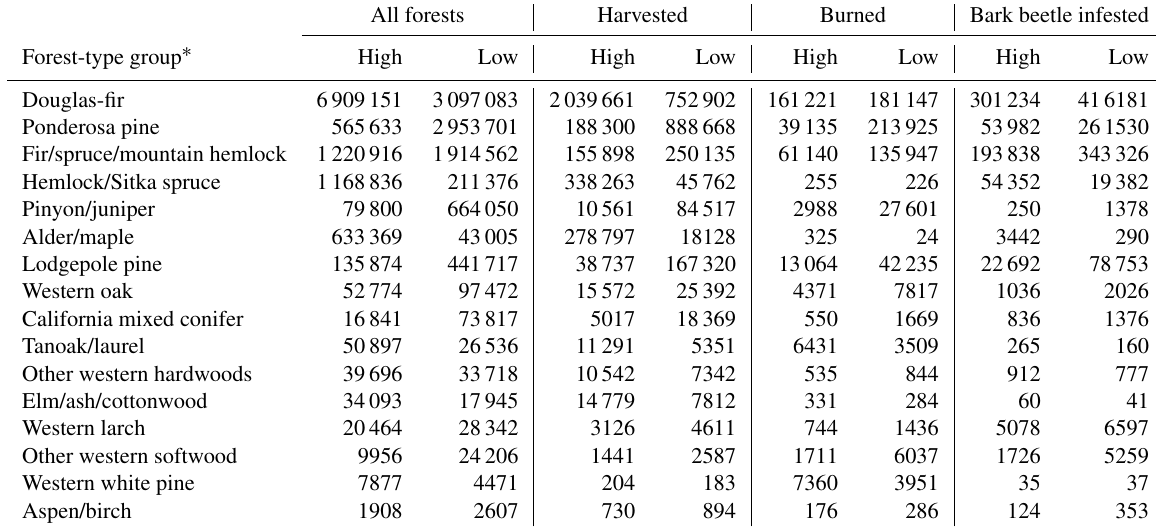
Figs. S7, S8, S9, S10, S11, and characteristic trajectories